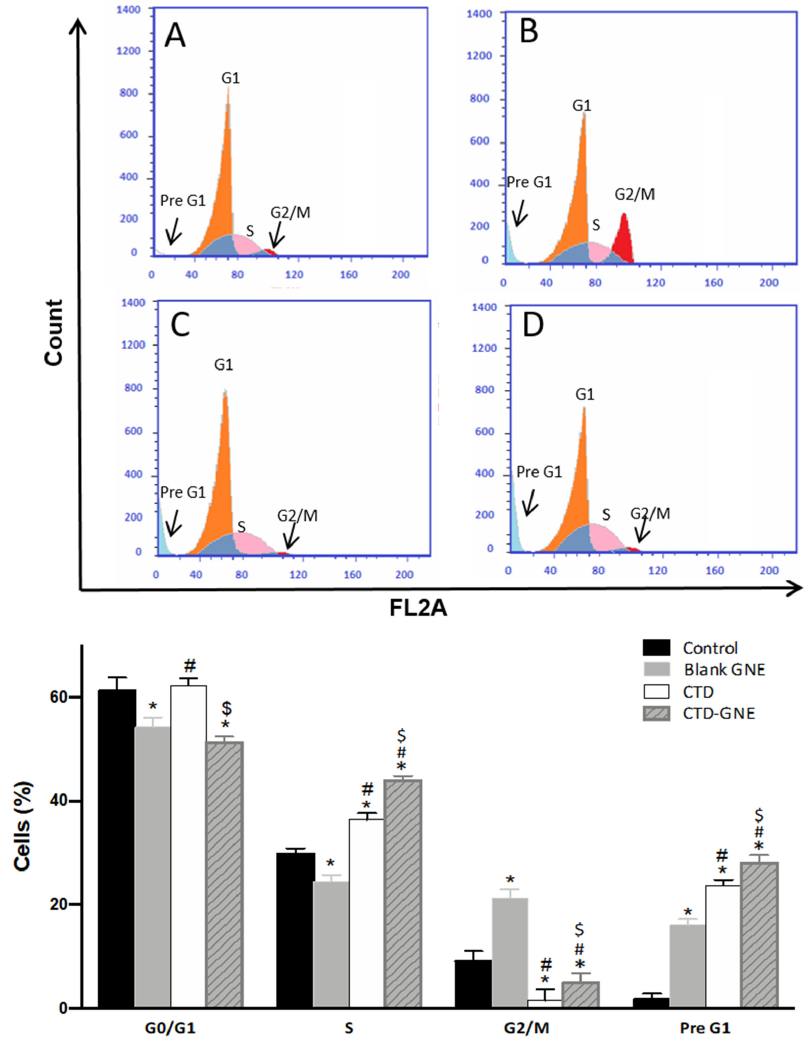
Figure 5. Graphical presentation of the A549 cell cycle phases in ( A ) control, ( B ) blank GNE, ( C ) CTD, ( D ) CTD-GNE using a flow cytometry analysis. All data are expressed as the mean ± SE of three independent experiments. * p < 0.05 is considered significantly different from the control, # p < 0.05 is considered significantly different from blank GNE, and $ p < 0.05 is considered significantly different from CTD.